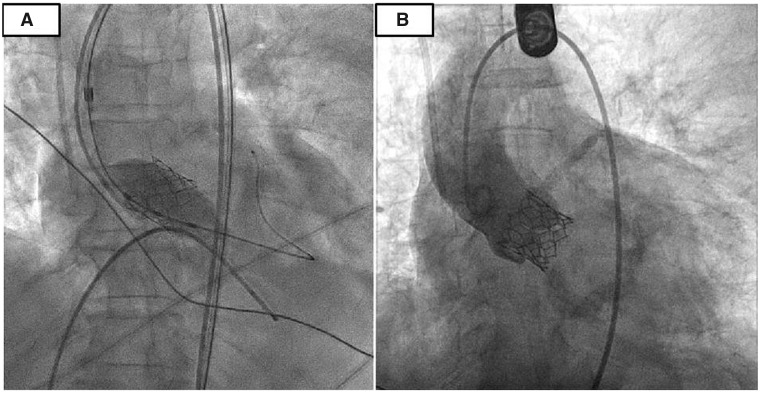
Balloon expandable MyvalvTM (A). MyvalTMin situ; no paravalvular regurgitation (B).